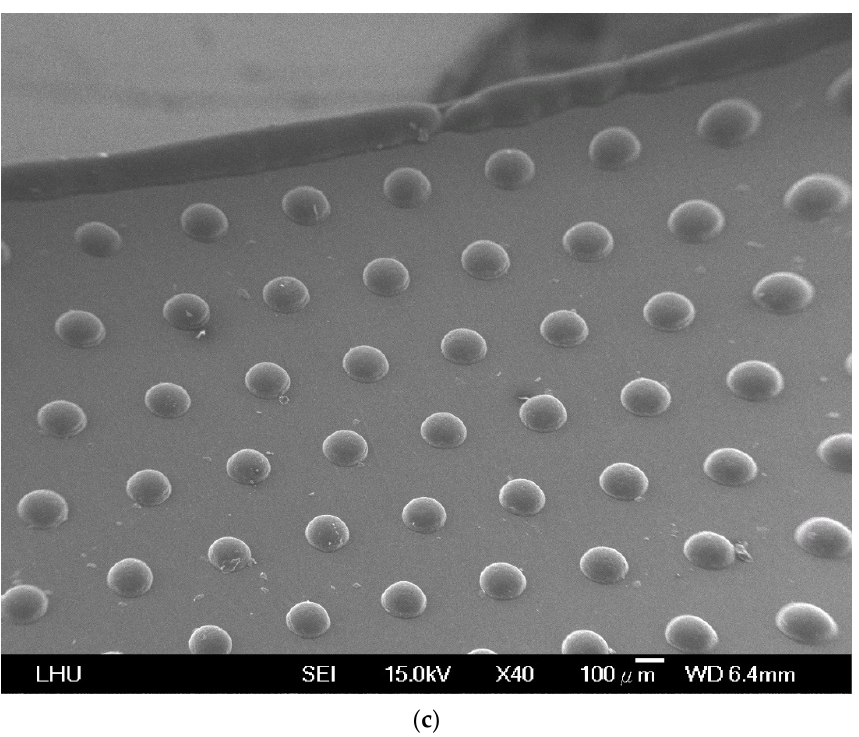
Figure 10. The molded light guide plate. ( a ) Light guide plate; ( b ) Microstructure on thin end; ( c ) Microstructure on thick end.